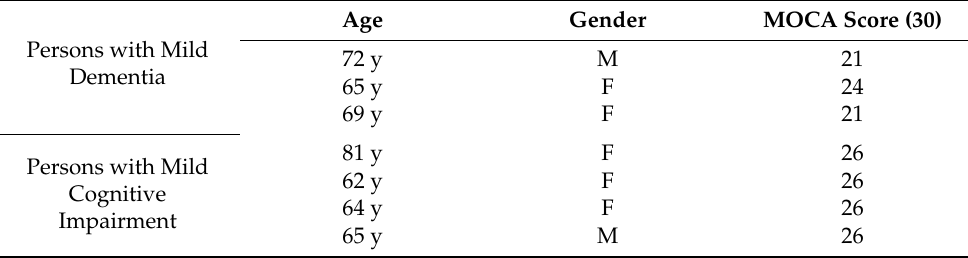
Table 1. Demographic details of the participants and their baseline cognitive (MOCA)